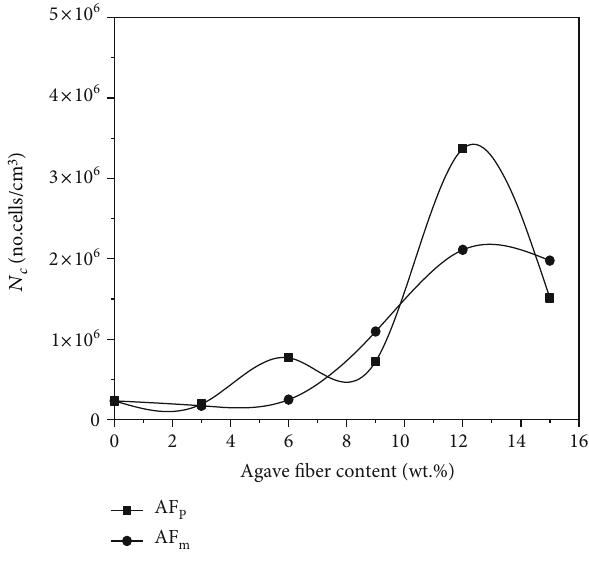
Figure 6: N C as function of the AF wt. %